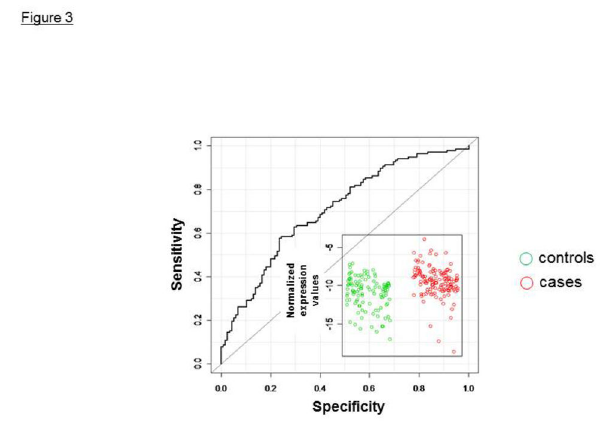
Figure 3. Receiver operating characteristic (ROC) analysis for DLG7. The area under the curve was 0.74 (95% CI, 068– 0.80). Inset: Scatter plot of the normalized expression values for cases (red) and controls